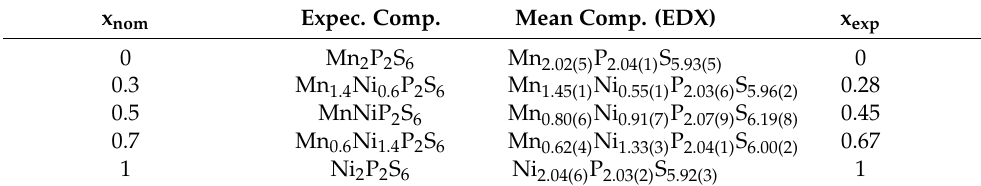
Table 1. Compositional analysis of as-grown single crystals of (Mn 1 − x Ni x ) 2 P 2 S 6 .